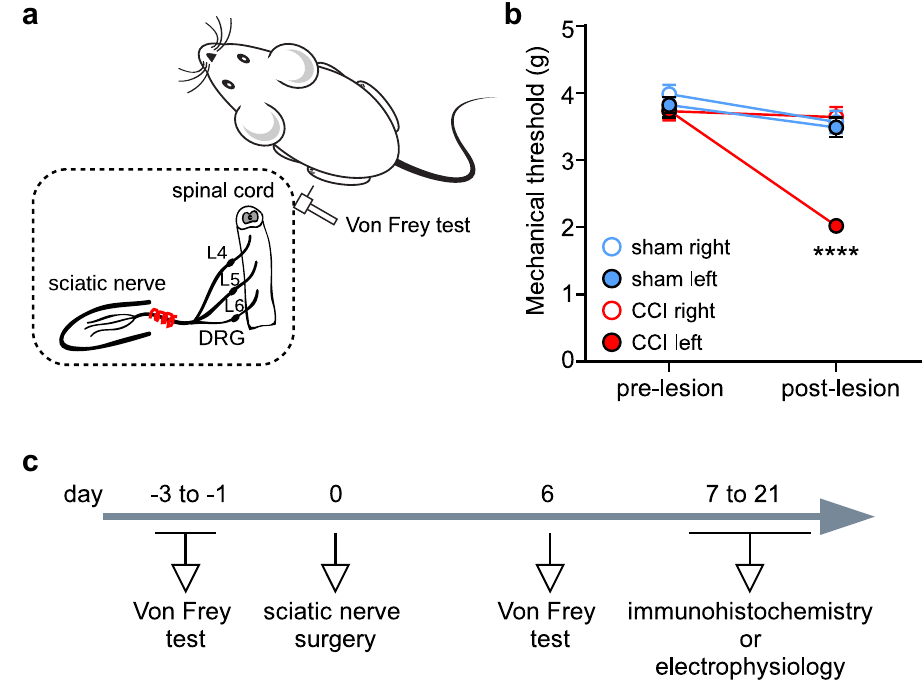
Figure 1. Chronic constriction injury (CCI) of the sciatic nerve induced mechanical allodynia of the injured hind paw. (a) CCI was induced by means of three loose ligatures on the sciatic nerve of the left hind paw. The lesion-induced allodynia was estimated from the mechanical threshold necessary to evoke paw withdrawal using an electronic Von Frey aesthesiometer. (b) After surgery, there was a reduction in the mechanical threshold of the injured (but not the contralateral) hind paw in CCI animals compared to sham (CCI n = 22; Sham n = 22; **** p < 0.0001, 2-way ANOVA). (c) Timeline of the experimental